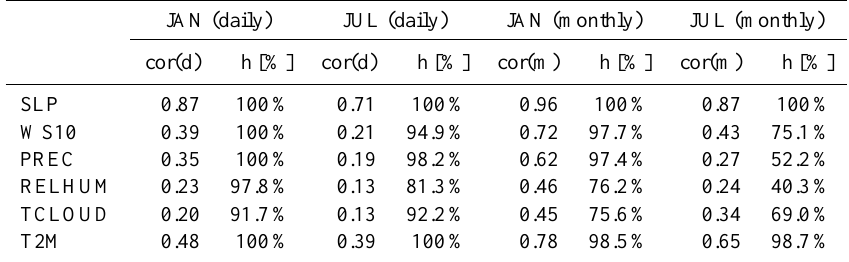
Table 1. Mean correlation between RCAO (RCAX for T2M) and HiResAFF on daily (left) and monthly (right) scale for January and July. Additionally shown is the amount of local tests h [%] showing significant correlations with p < 0 . 05. Field significance with p < 0 . 05 can be claimed for all cases according to bootstrapping test.